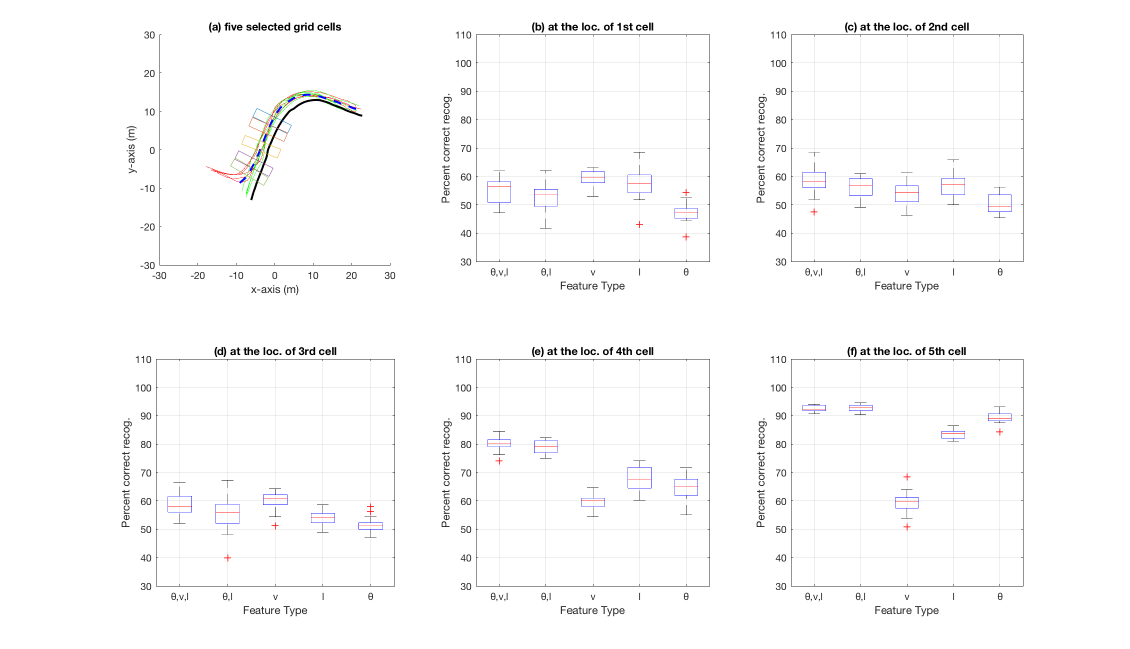
Figure 15. Aggregate results on bicycle dataset using decision trees, with cell width w = 2.4